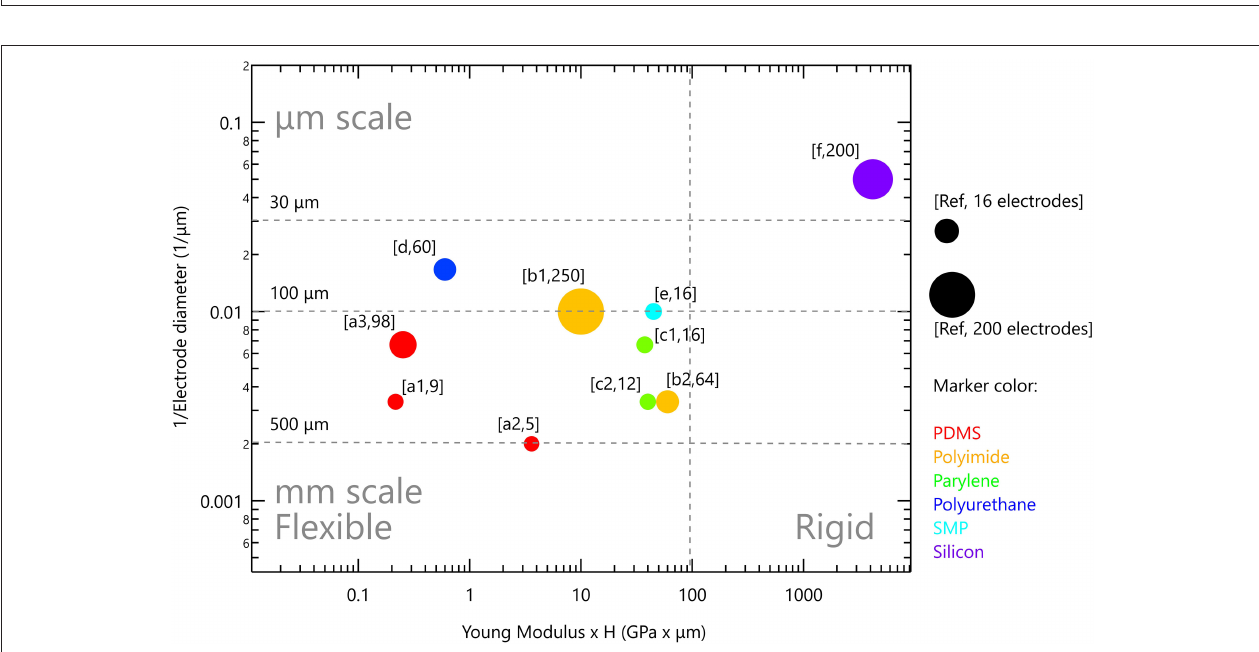
FIGURE 3 | Flexible substrate materials used in implantable devices. Scale of elastic modulus for commonly used substrates and their chemical structures: PDMS, parylene C, polyimide PI 2611, silk fibroin and monomers used to make thiol-ene acrylate polymer (SMP).